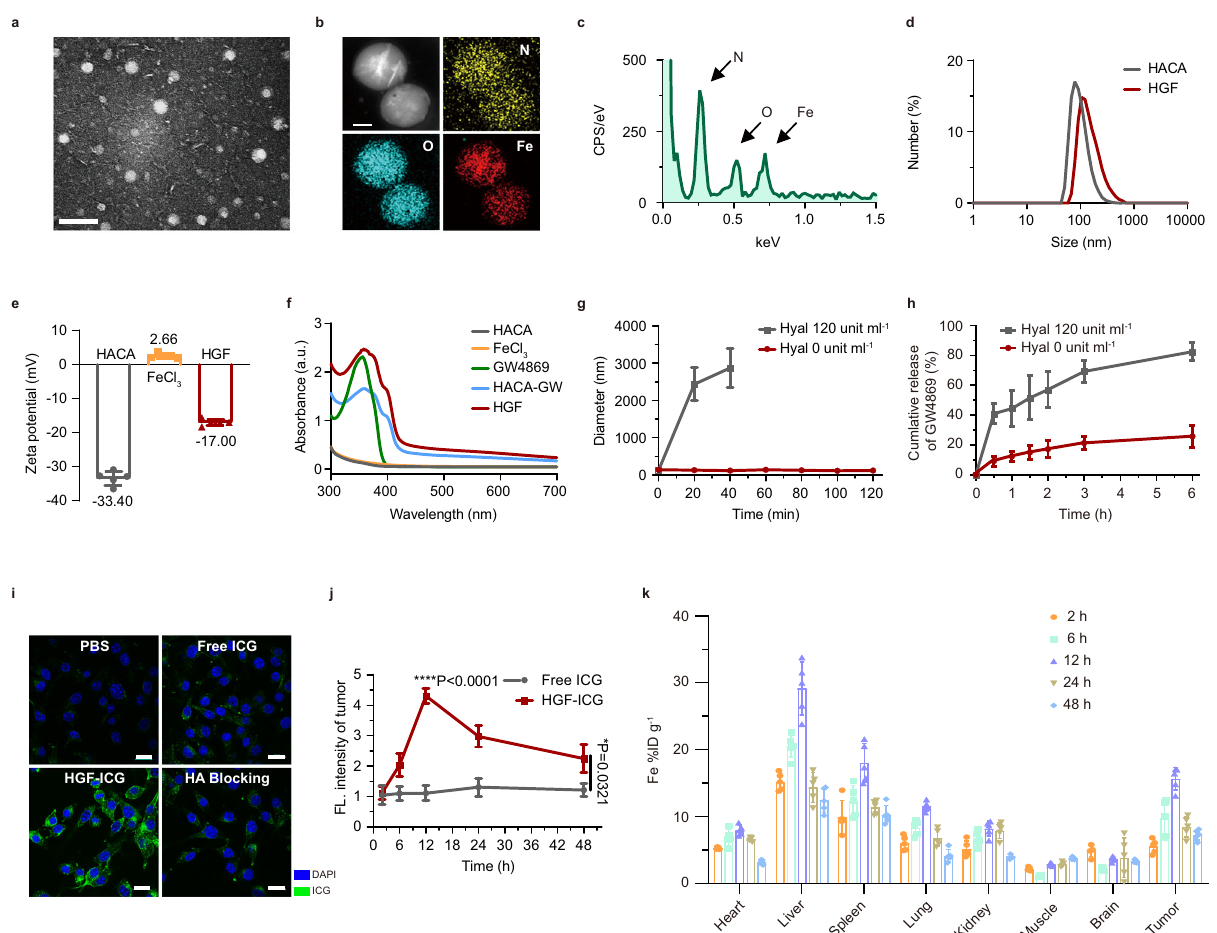
Fig. 2 Characterization and biodistribution of HGF NPs. a – c Transmission electron microscopy (TEM) image ( a scale bar: 200 nm), representative elemental mapping ( b scale bar: 20 nm) and energy-dispersive X-ray spectroscopy (EDS) analysis c of HGF NPs. Images were representative of three experiments. d The size of HACA and HGF NPs determined by dynamic light scattering (DLS). Experiments were performed fi ve times independently with similar results. e Zeta potential of HACA, FeCl 3 , and HGF NPs. n = 5 biologically independent samples per group at each time point. Data were presented as mean ± SD. f The UV – Vis absorption spectra of HACA, FeCl 3 , GW4869, HACA-GW, and HGF NPs. Experiments were performed three times independently with similar results. g and h Particle size changes g of HGF NPs and release patterns h of GW4869 from HGF NPs in the presence or absence of Hyal (hyaluronidase-1). n = 3 biologically independent samples per group at each time point. Data were presented as mean ± SD. i Cell uptake of HGF NPs labeling with ICG. Scale bar: 20 μ m. Images were representative of three experiments. j Quanti fi cation of the corresponding fl uorescence intensity of tumor sites at 2, 6, 12, 24, and 48 h after injection with free ICG and ICG labeled HGF NPs. n = 4 biologically independent animals per group at each time point. Data were presented as mean ± SD. Statistically signi fi cant differences between groups were identi fi ed by one-way ANOVA with Tukey ’ s post hoc test. * P < 0.05, ** P < 0.01, *** P < 0.001, and **** P < 0.0001. k Biodistribution of HGF NPs in various tissues after 2, 6, 12, 24, and 48 h intravenous administration. HGF NPs concentrations were normalized as the percentage of the injected dose of Fe per gram of each organ (%ID g – 1 ). n = 5 biologically independent animals per group at each time point. Data were presented as mean ±